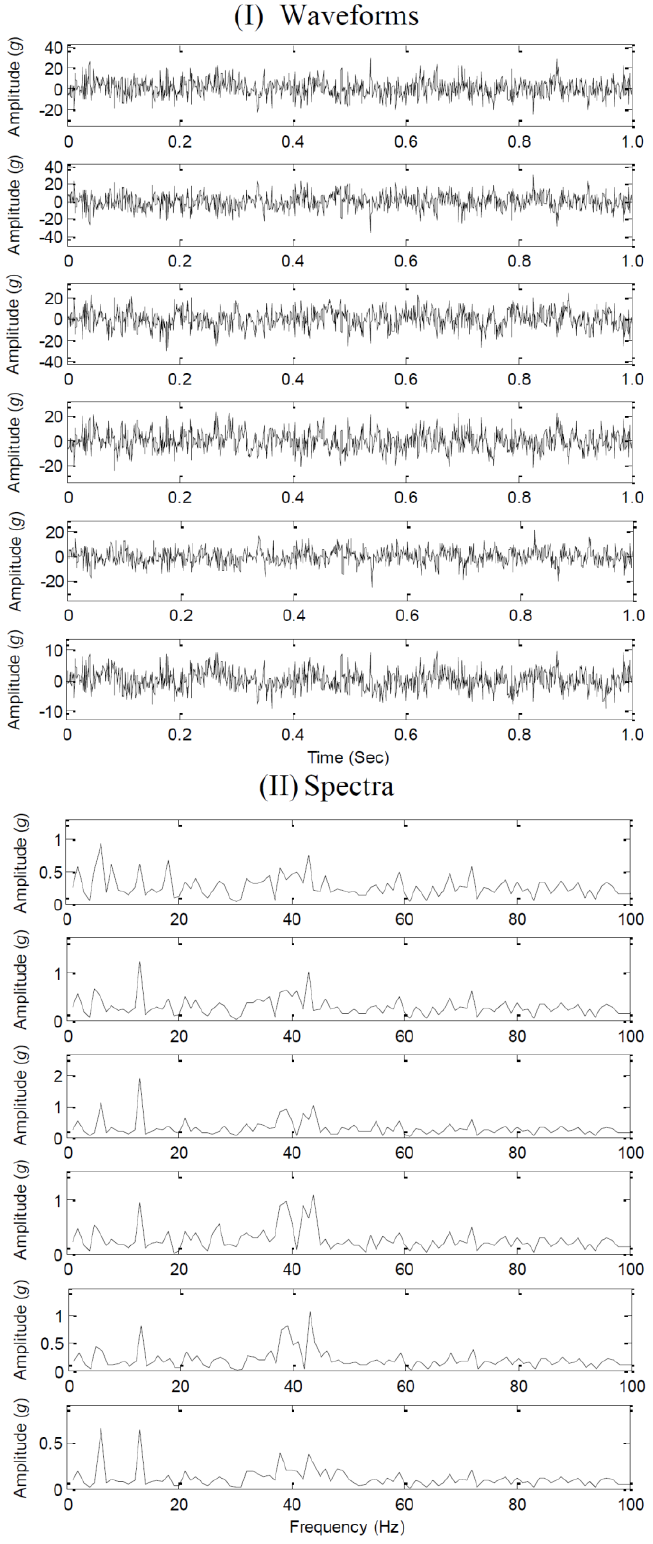
Figure 2. The waveforms and spectra of the mixed